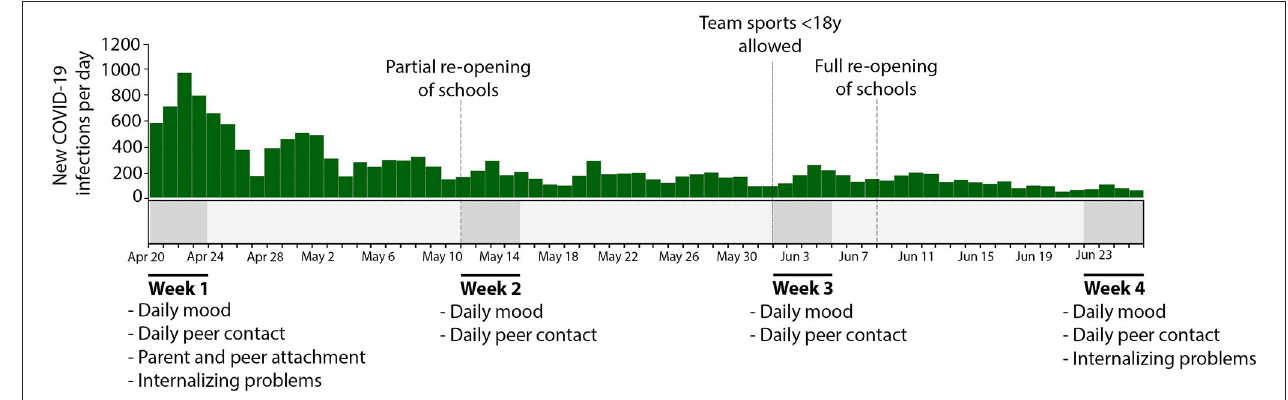
FIGURE 1 | Overview of assessment weeks and daily new registered COVID-19 infections and containment related events during the study period from April to June